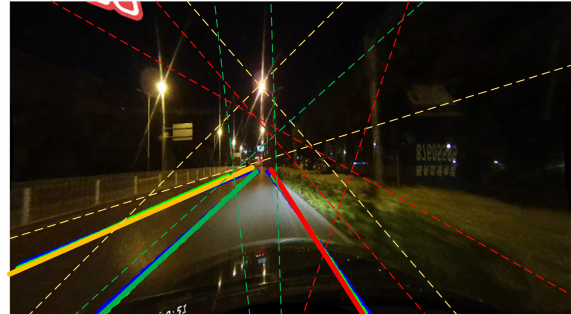
Figure 7. Intermediate visual results of GGFA. The three most similar anchor lines are represented by dashed lines. Different lanes are drawn by different colors.